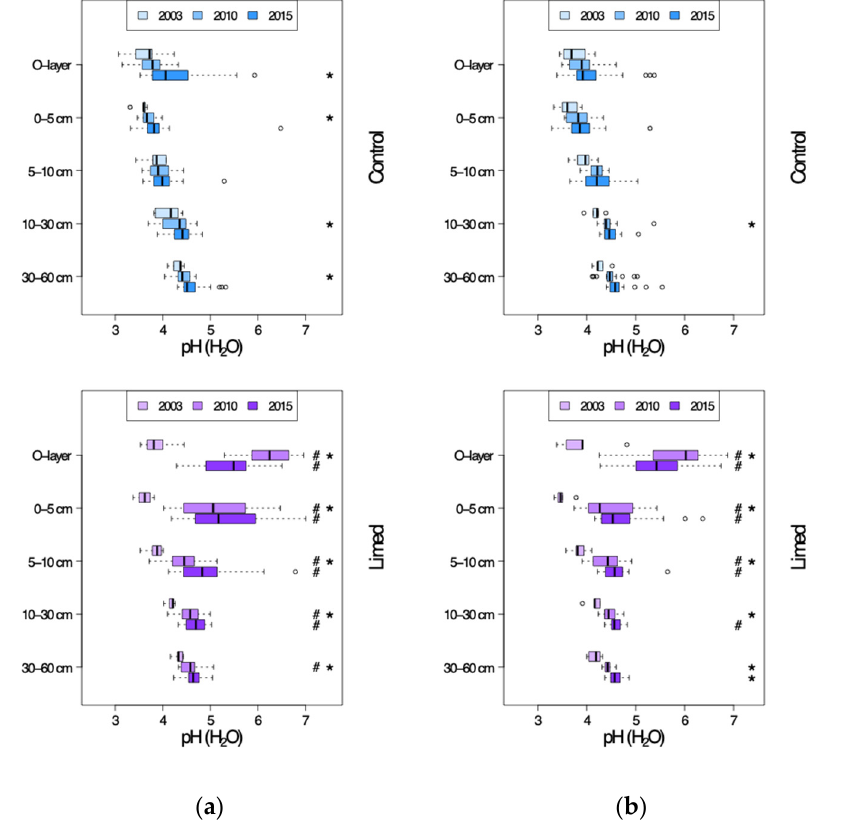
Figure 2. pH-H 2 O in the soil profiles of control and lime treated plots in 2003–2015. ( a ) G1 study sites. ( b ) G2 study sites. #—limed plots significantly di ff erent from control; *—significant di ff erences between current and previous sampling